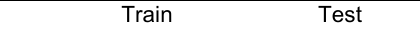
Table 1. Four groups of cross-validation